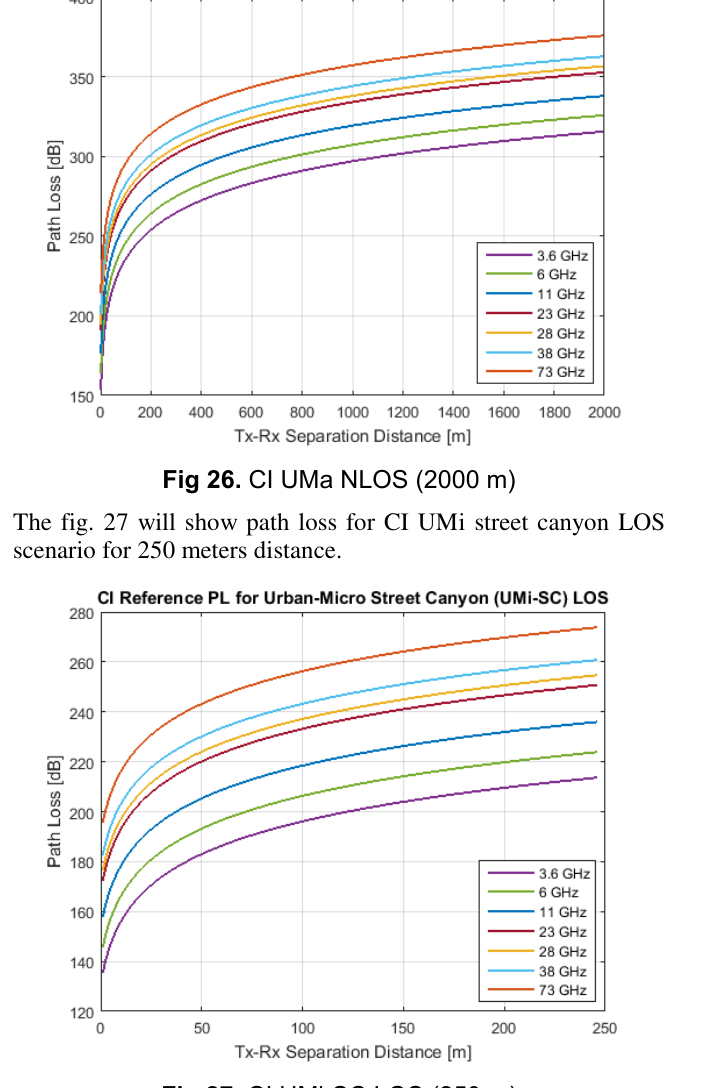
Fig 27. CI UMi-SC LOS (250 m) The fig. 28 will show the path loss for CI UMi street canyon NLOS scenario for a distance of 600 meters.